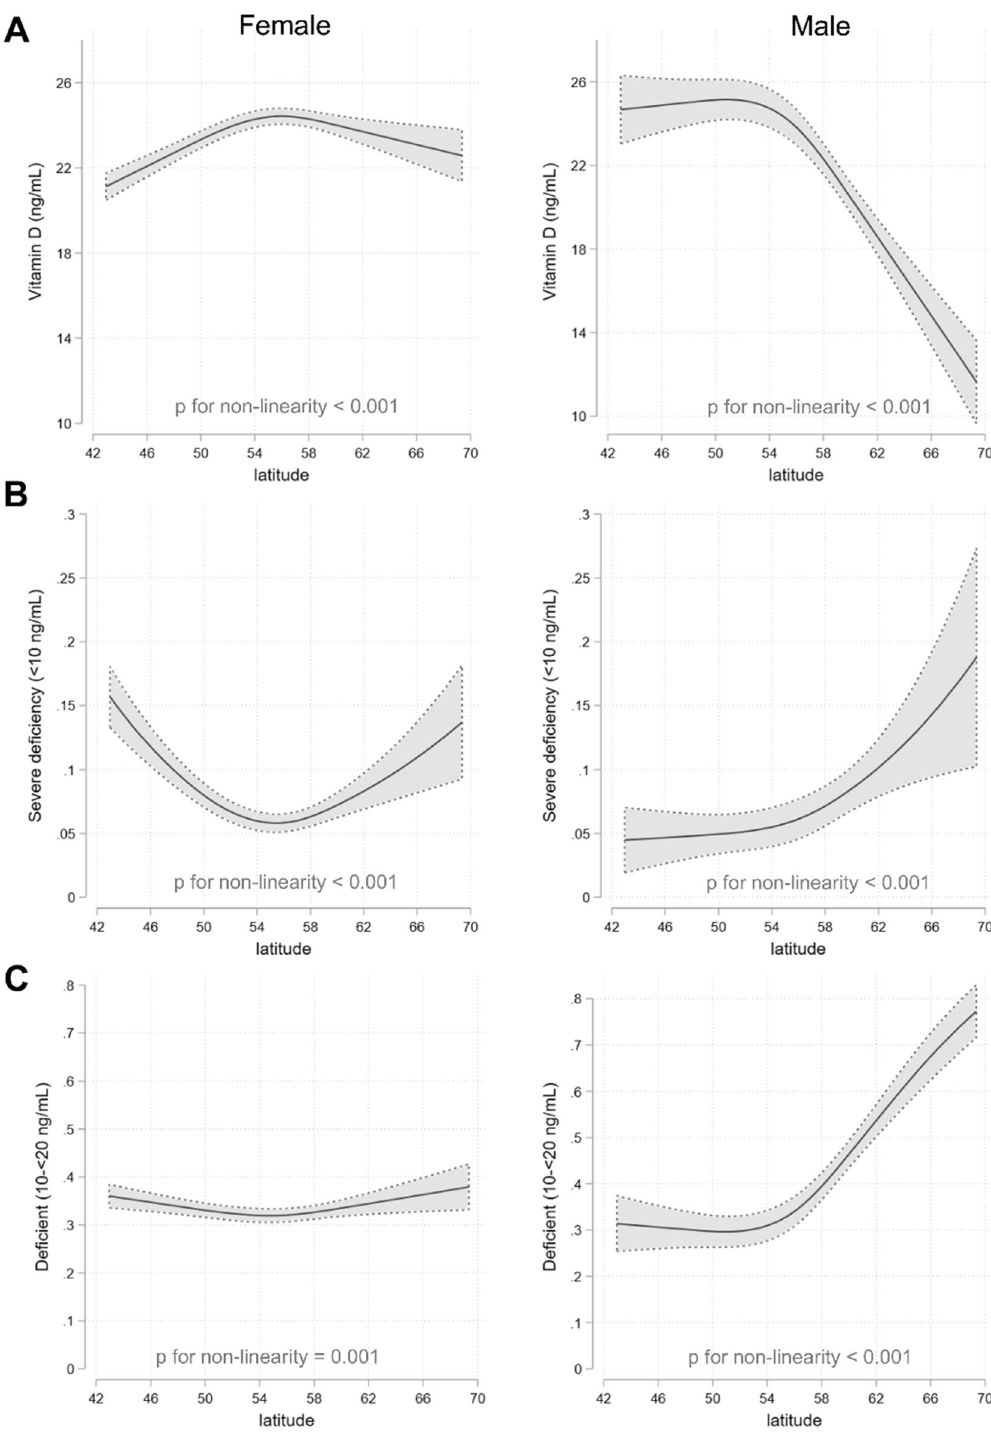
Figure 3. Restricted cubic splines showing association between latitude and mean 25(OH)D concentrations ( A ), proportion with severe deficiency (< 10 ng/mL) ( B ) and proportion with deficiency (10- < 20 ng/mL) ( C ). Shaded gray area represent 95% confidence intervals. Analyses are adjusted for age group, season and year of data collection. Data are from 2013 to 2018 and are from all months of the year. For all outcomes the p-value for interaction between latitude and sex was <